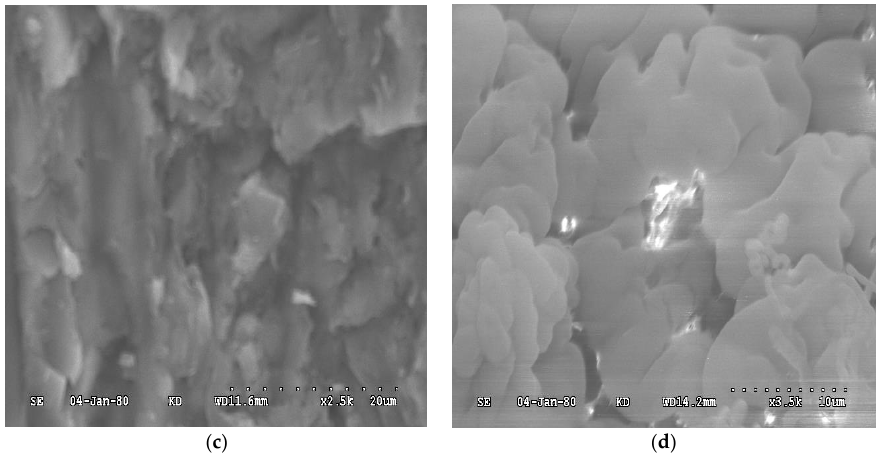
Figure 6. SEM image of the internal flake structure: ( a ) before soaking; ( b ) soaking for 5 days; ( c ) soaking for 10 days and ( d ) soaking for 15 days.